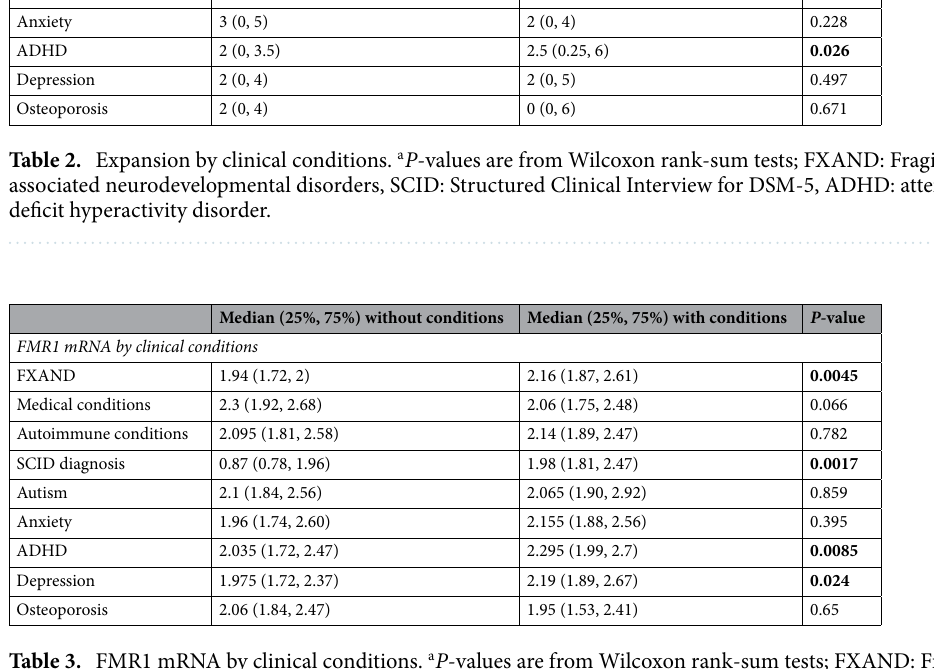
Table 3. FMR1 mRNA by clinical conditions. a P -values are from Wilcoxon rank-sum tests; FXAND: Fragile X associated neurodevelopmental disorders, SCID: Structured Clinical Interview for DSM-5, ADHD: attention deficit hyperactivity disorder.